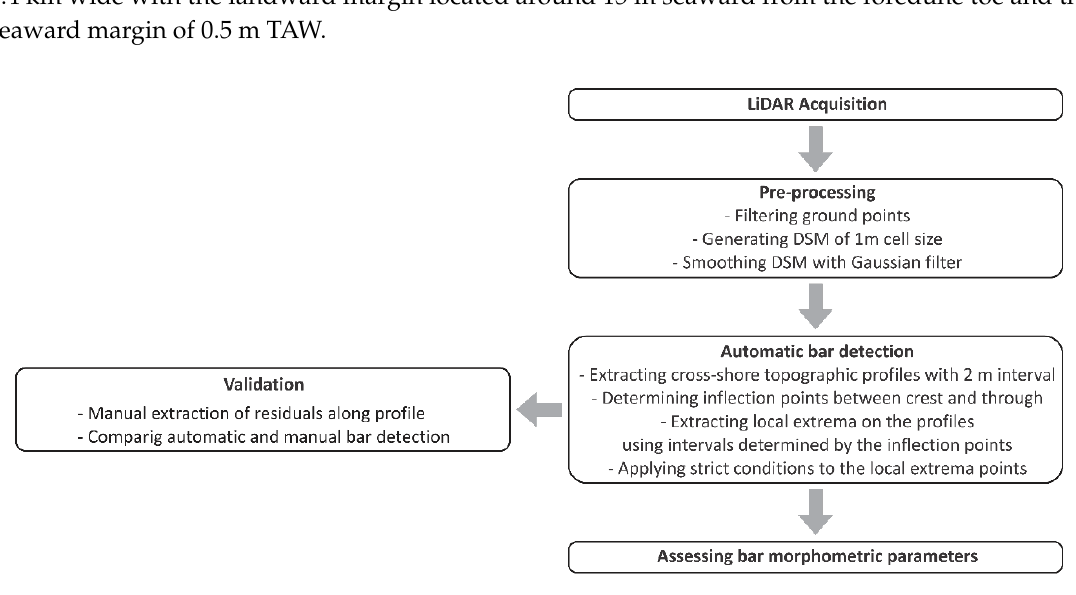
Figure 3. Workflow from LiDAR data processing to bar analysis.